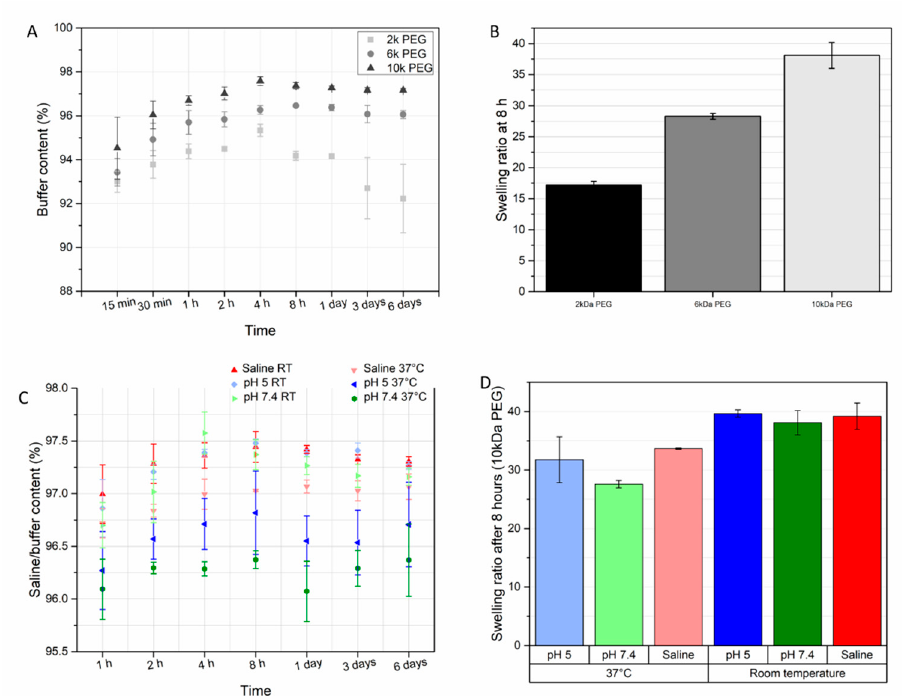
Figure 3. ( A ) The swelling of hydrogels formed with different dithiol functional PEGs in citrate- phosphate buffer (pH 7.4) at room temperature (RT); ( B ) the swelling ratios of the hydrogels after submersion in the buffer for 8 h at RT. ( C ) the swelling of the hydrogels formed with 10 kDa PEG at different pH and temperature; ( D ) the swelling ratios of hydrogels formed with 10 kDa PEG at different pH and temperature.